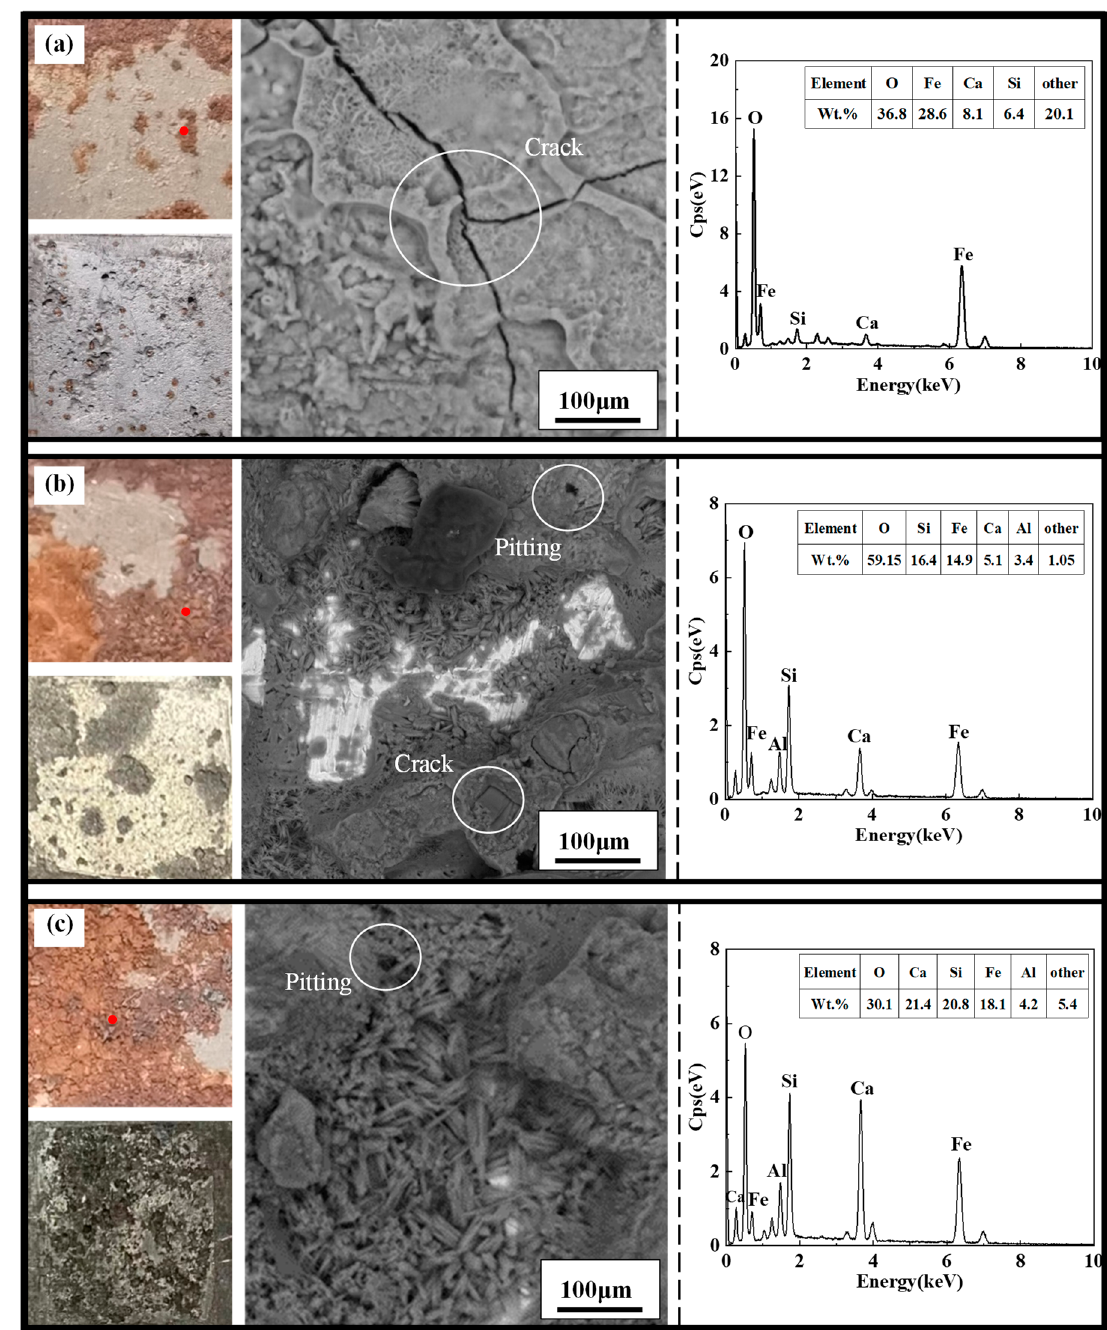
Figure 13. Macroscopic and microscopic corrosion morphology and elemental analysis results of X70 steel under capillary action in soil column at the height of 12 # : ( a ) 0%, ( b ) 0.3%, ( c ) 1.0% NaCl.